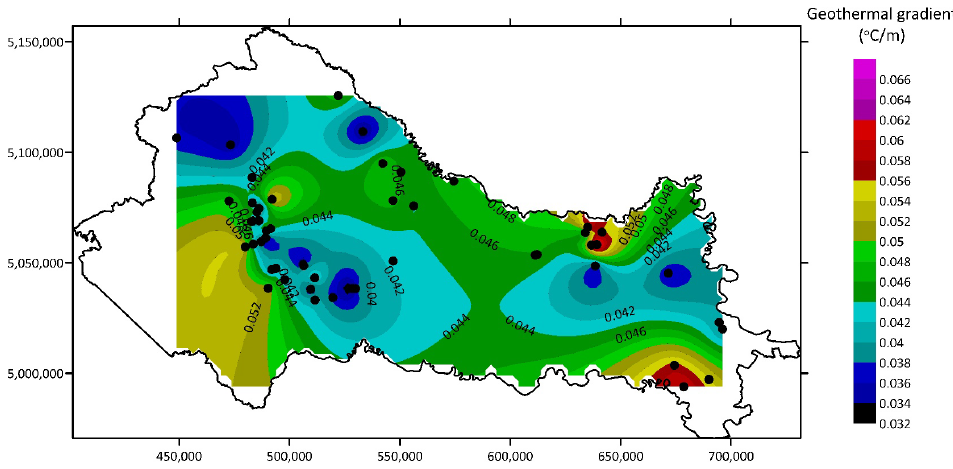
Figure 13. Geothermal gradient map for post-rift phase.